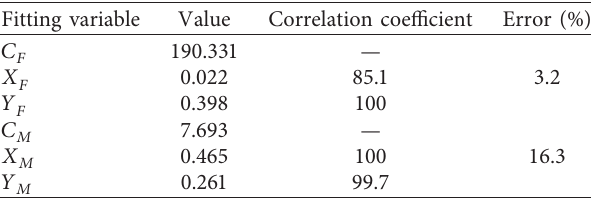
Table 5: The fitting results of axial force and torque.